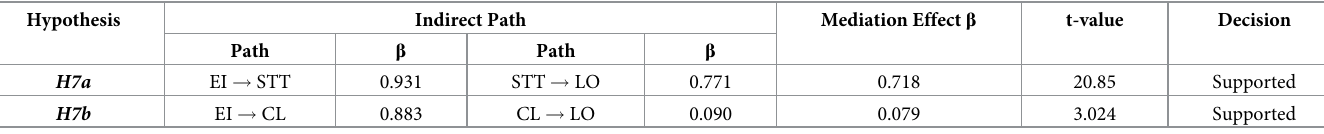
Table 7. Summary of mediation